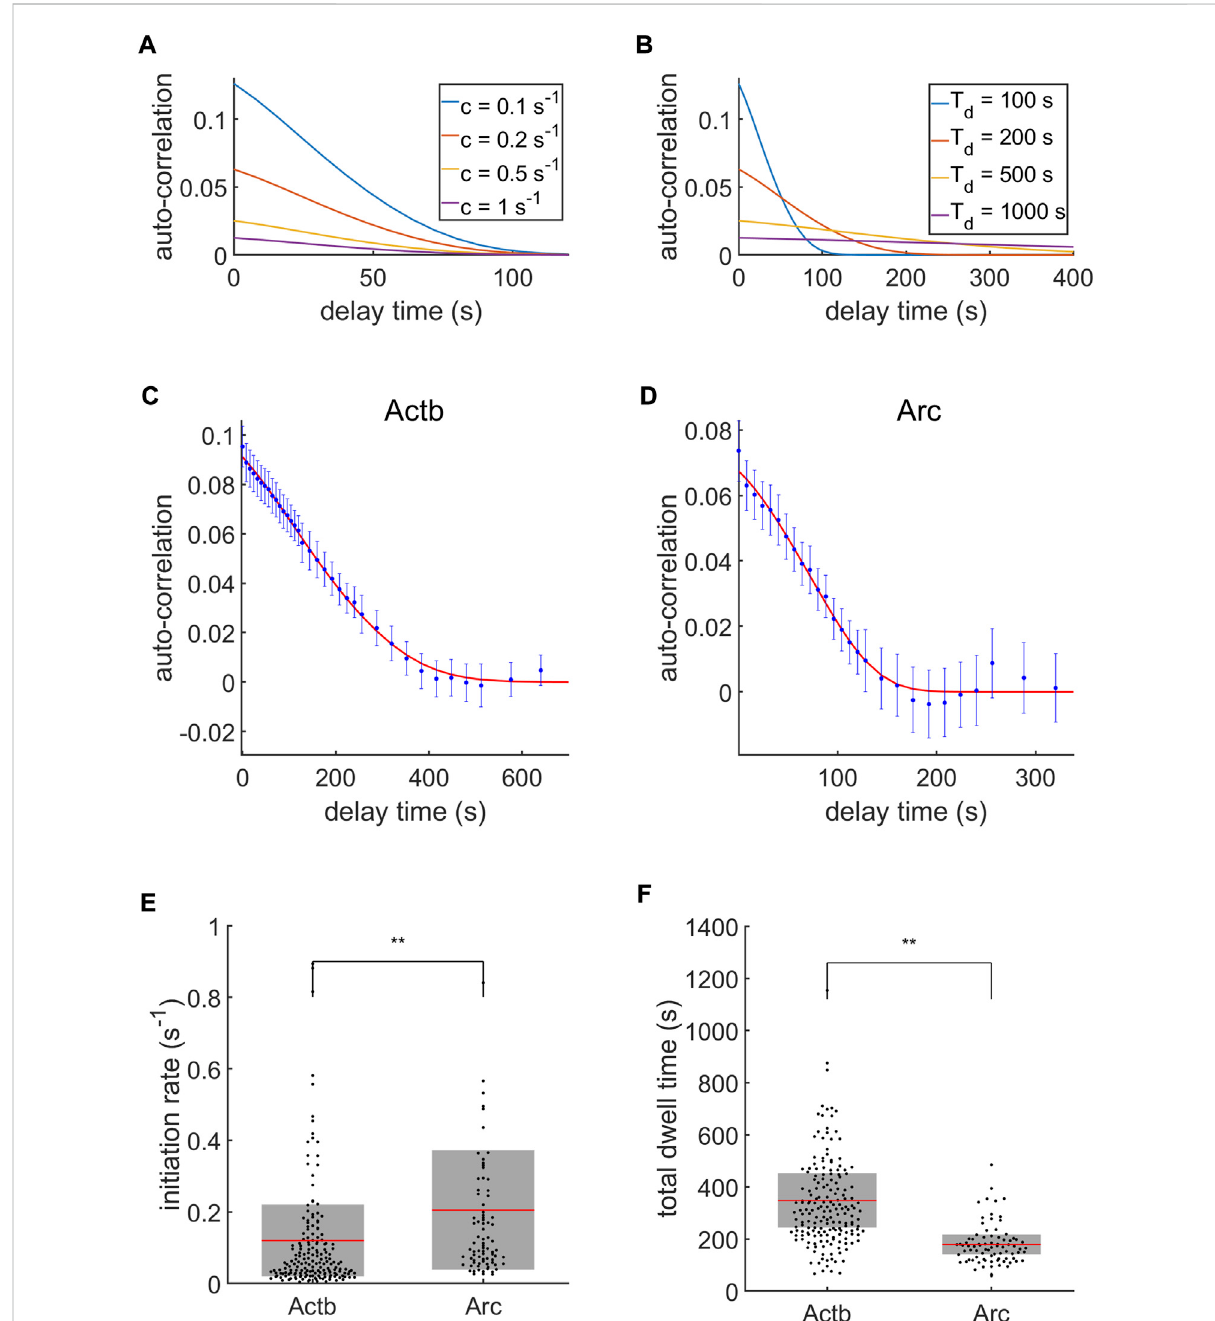
FIGURE 6 Autocorrelationanalysis oftranscription. (A,B) Autocorrelationmodelfunctionbehaviorswithvaryinginitiationrate c (A) andtotaldwelltime T d (B) . The termination time was set to T t (cid:2) 0. For (A) , the total dwell time was fi xed at T d (cid:2) 100 s, and for (B) , the initiation rate was c (cid:2) 0 . 1 s − 1 . (C,D) Representative autocorrelation data (blue dots) and thebest fi tcurves (red lines) of Actb (C) and Arc (D) transcription. (E,F) The initiationrates (E) and the total dwell times (F) of Actb (n = 183 ON-time traces) and Arc (n = 82 ON-time traces). The mean (red line) and standard deviation (SD, gray box) values are indicated (** P < 0 . 01, Wilcoxon rank-sum